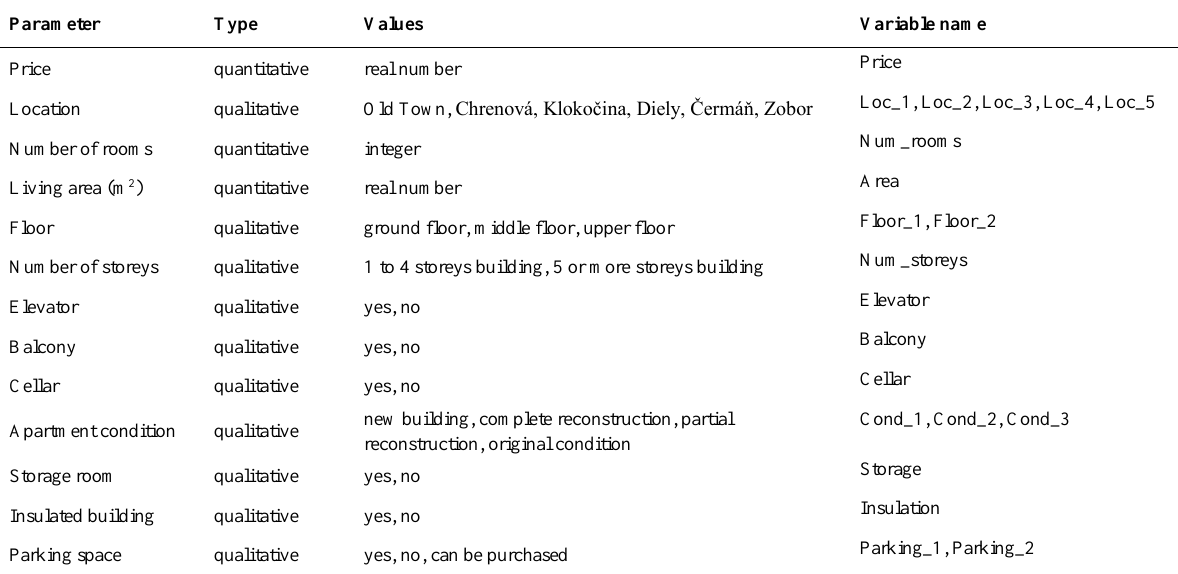
Table 1. Property parameters.